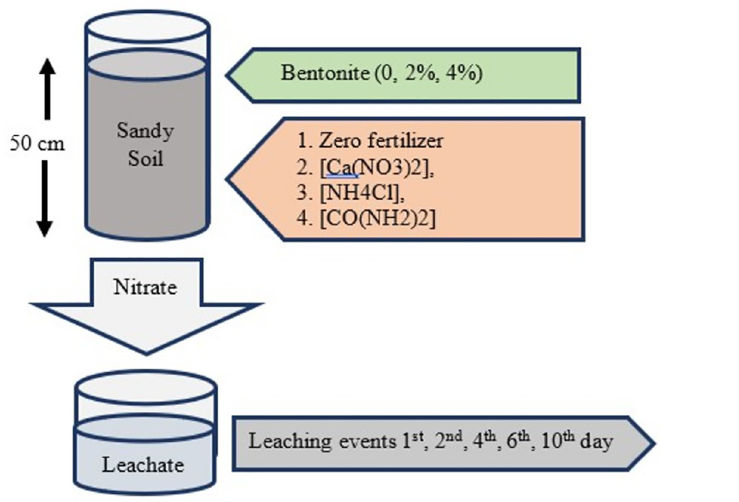
Fig 1. Graphical display of lysimeter